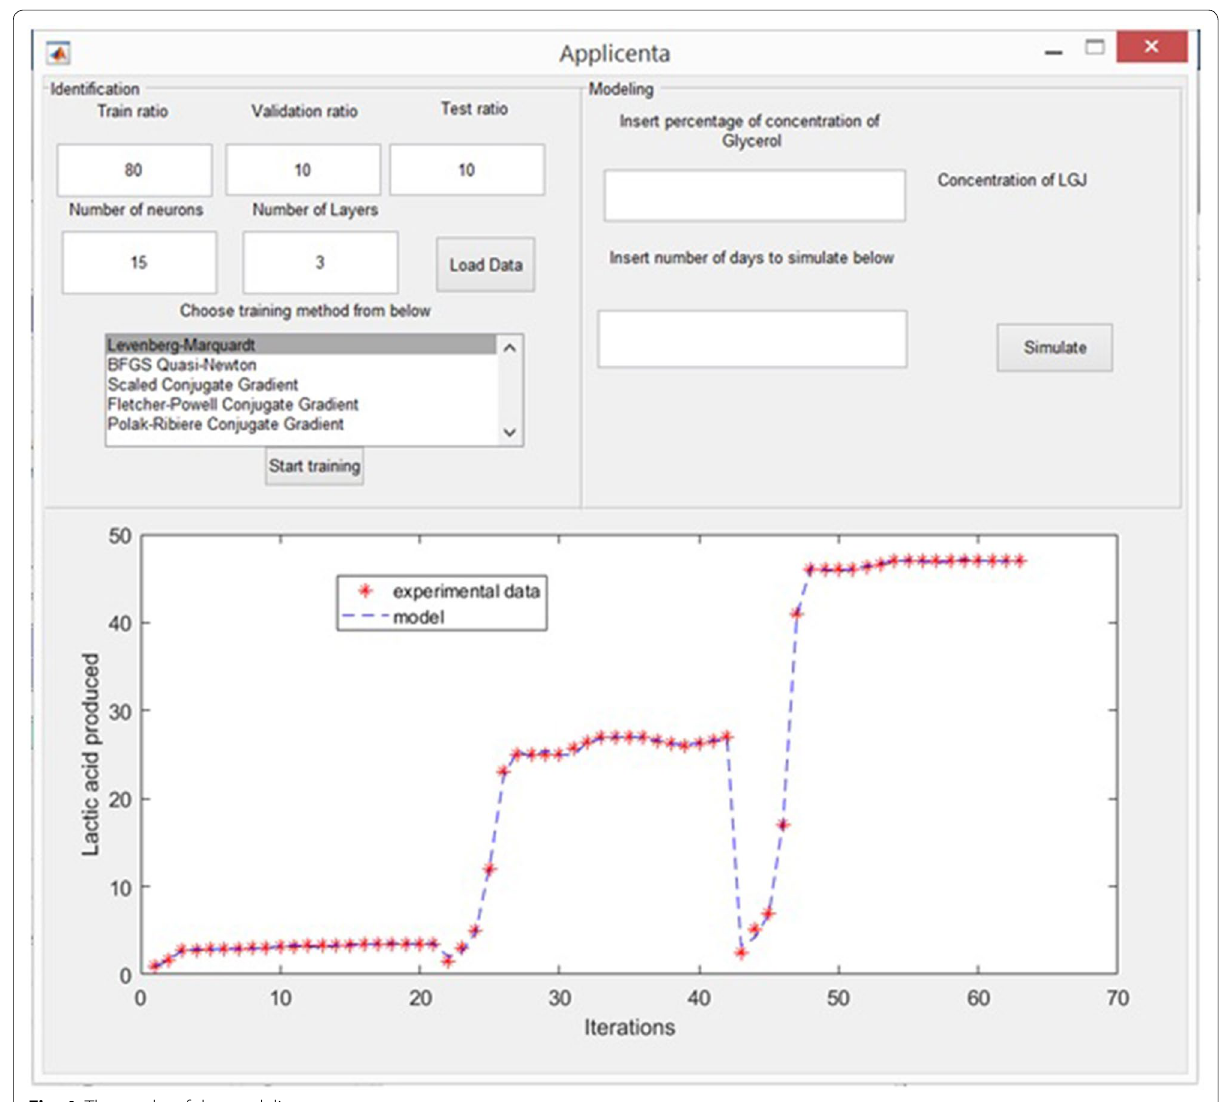
Fig. 4 The results of the modeling